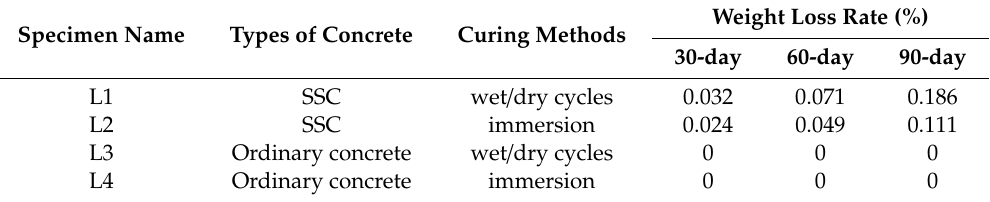
Table 4. Steel corrosion weight loss rate of specimens.